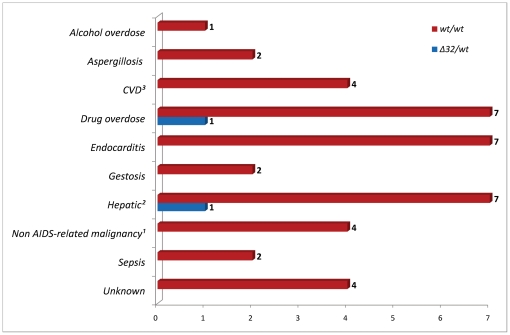
Causes of non AIDS-related deaths and CCR5 wt/wt vs. CCR5 Δ32/wt genotype.
1 Hepatic: liver cirrhosis (n = 5), liver insufficiency (n = 3); 2 CVD: stroke (n = 1), coronary artery disease (n = 2), pulmonary embolism (n = 1); 3 Non AIDS-related malignancy: Hodgkin lymphoma (n = 1), gastric cancer (n = 1), leukemia (n = 1), testicular cancer (n = 1). Gestosis: death related to pre-eclampsia or eclampsia during pregnancy.